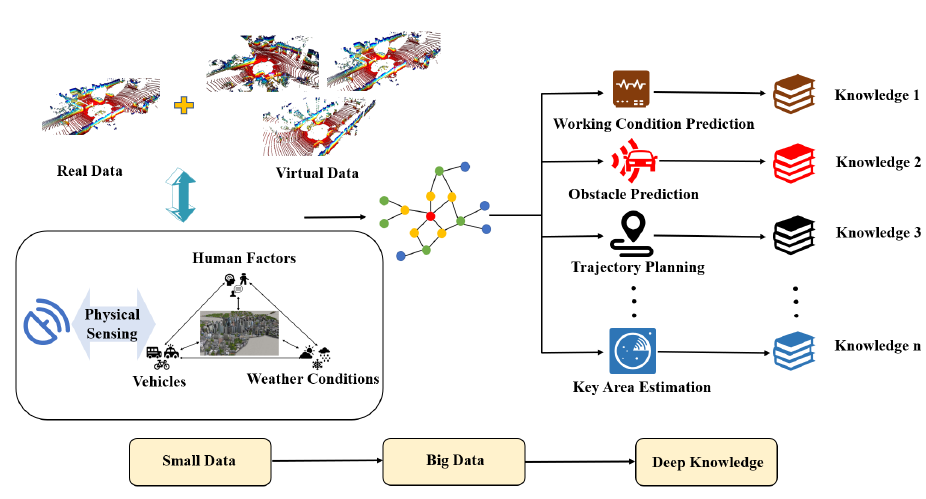
Figure 5. Predictive Radars: the framework and process.